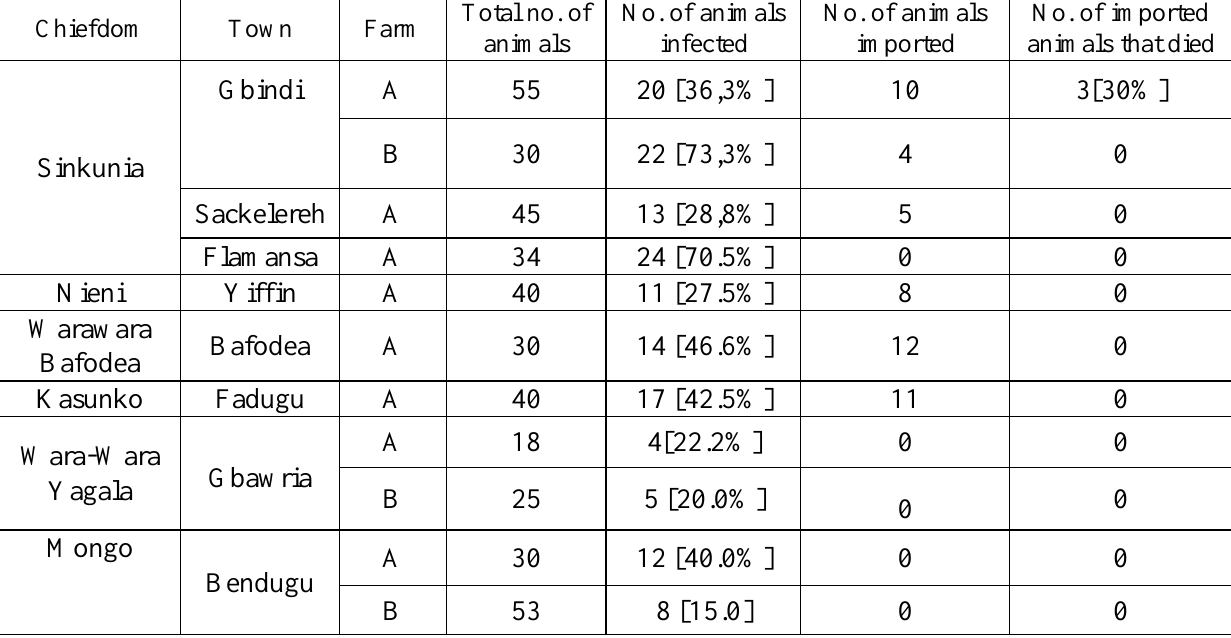
Table -1: Distribution of cattle by chiefdoms and towns in Koinadugu District, Sierra Leone: